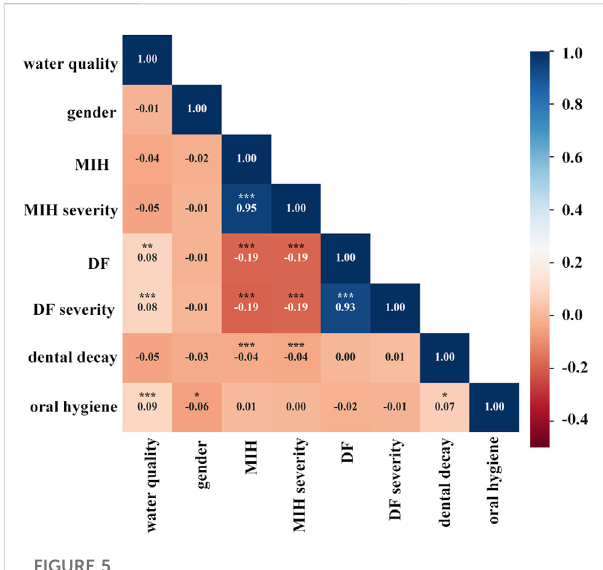
FIGURE 5 Correlation heatmap of clinical characteristics using Spearman correlations. Heatmap shows the positive (red) or negative (blue) correlations of all parameters, with color intensity re fl ecting the strength of the correlation ( − 0.4 to +1). MIH and MIH severity were negatively correlated with DF and DF severity and also had negligible associations with dental caries. * p < 0.05; ** p < 0.01; *** p <